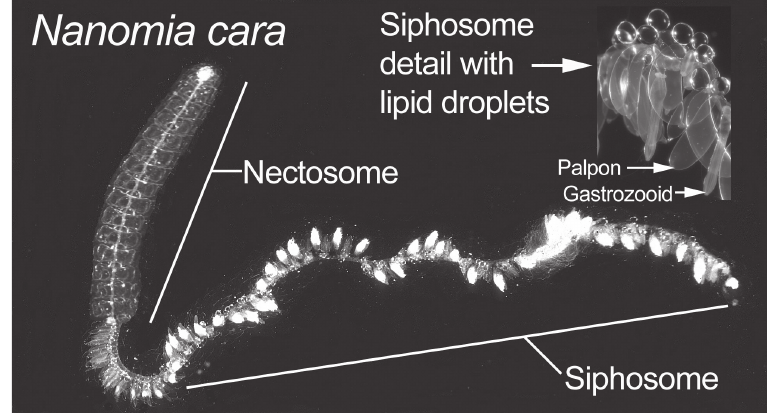
Fig . 2. – Nanomia cara showing nectosome, siphosome, gastrozooids, palpons and lipid